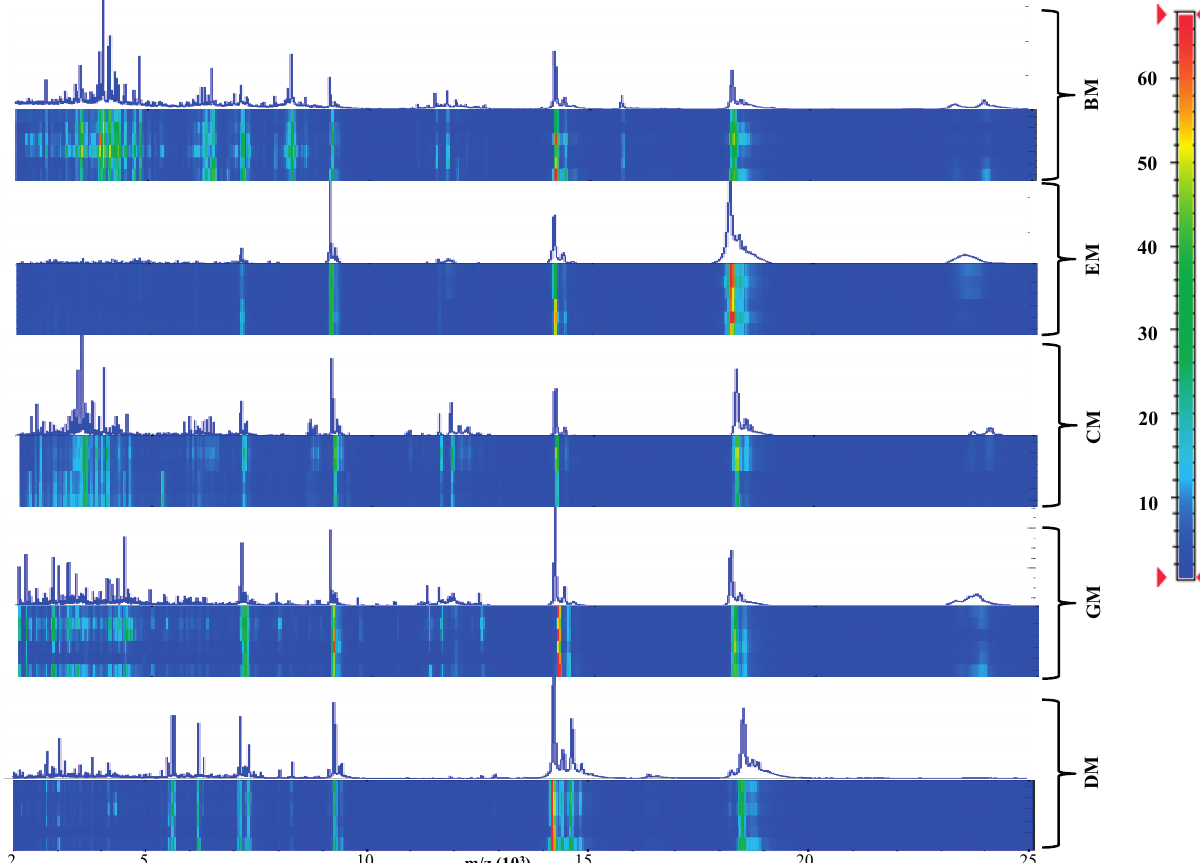
Figure 1. Pseudo-gel like and mass spectrometry (MS) proteomic profiling of crude milk from six she-donkey, goat, cow, ewe and buffalo animals. The mass values ( m / z ) are reported on the X axis, while the color bar on the Y axis indicates the peak